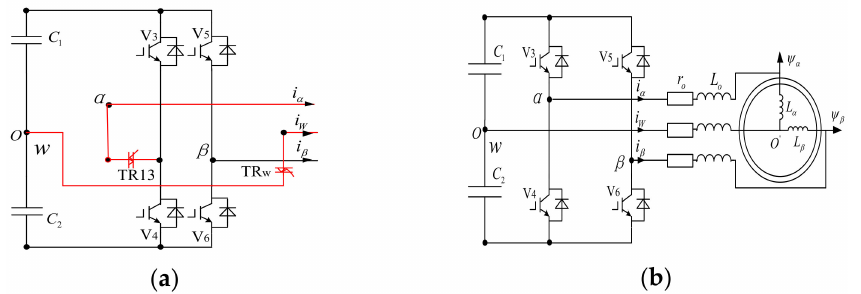
Figure 2. Inverter reconstruction process when the fault occurs in V1. ( a ) Switching process; ( b ) Re- construction